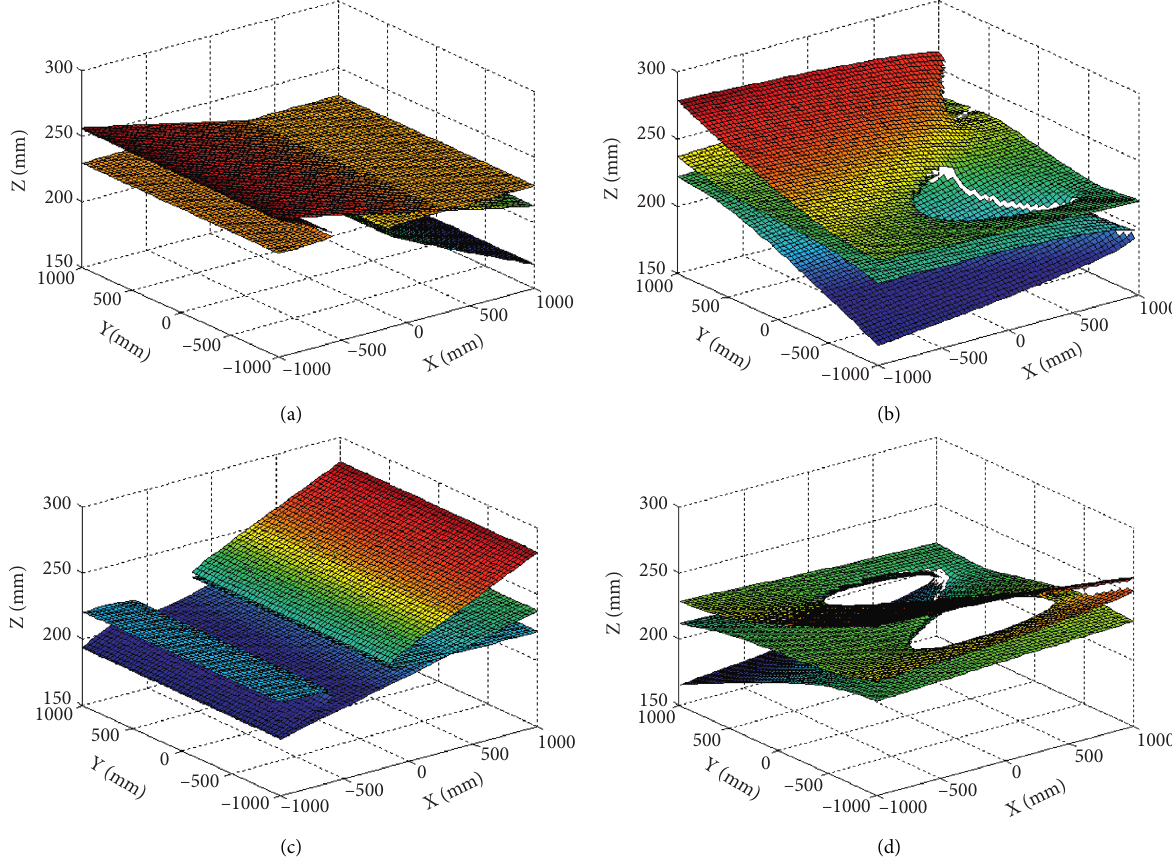
Figure 11: The singularity locus with different orientations. (a) ( α � c � 0, β � 2.52 ° ), (b) ( α � 2.52 ° , β � 0, c � − 4.47 ° ), (c) ( α � c � 0, β � − 2.52 ° ), (d) ( α �− 2.52 ° , β � 0, c � 4.47 ° ).